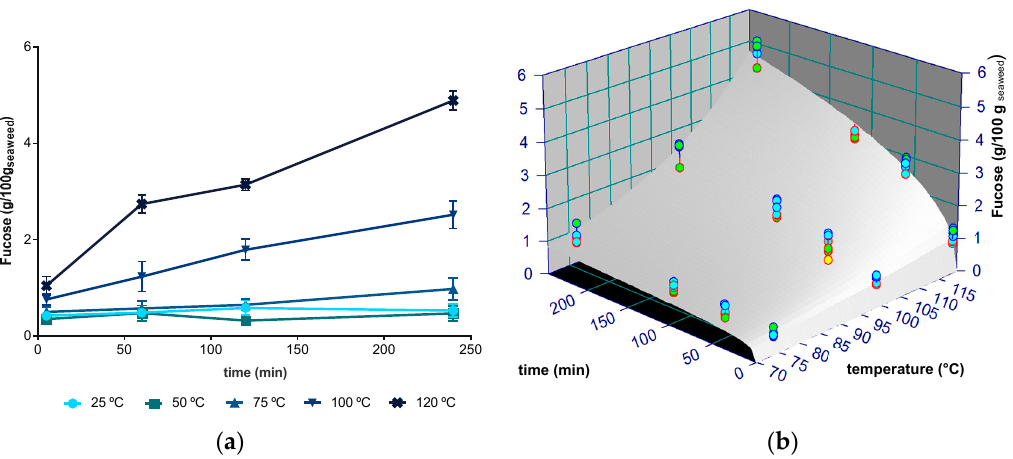
Figure 2. ( a ) Amount of fucose recovered from F. vesiculosus (g / 100 g of dried seaweed) at 25, 50, 75, 100, and 120 ◦ C between 5 minutes and 4 hours); ( b ) Fitting plot of power law with Arrhenius dependence to the fucose extract at 75, 100, and 120 ◦ C during 5 min to 4 h (240 min) (blue, green, and yellow, identify, respectively, 1, 2, and 3 standard deviations).